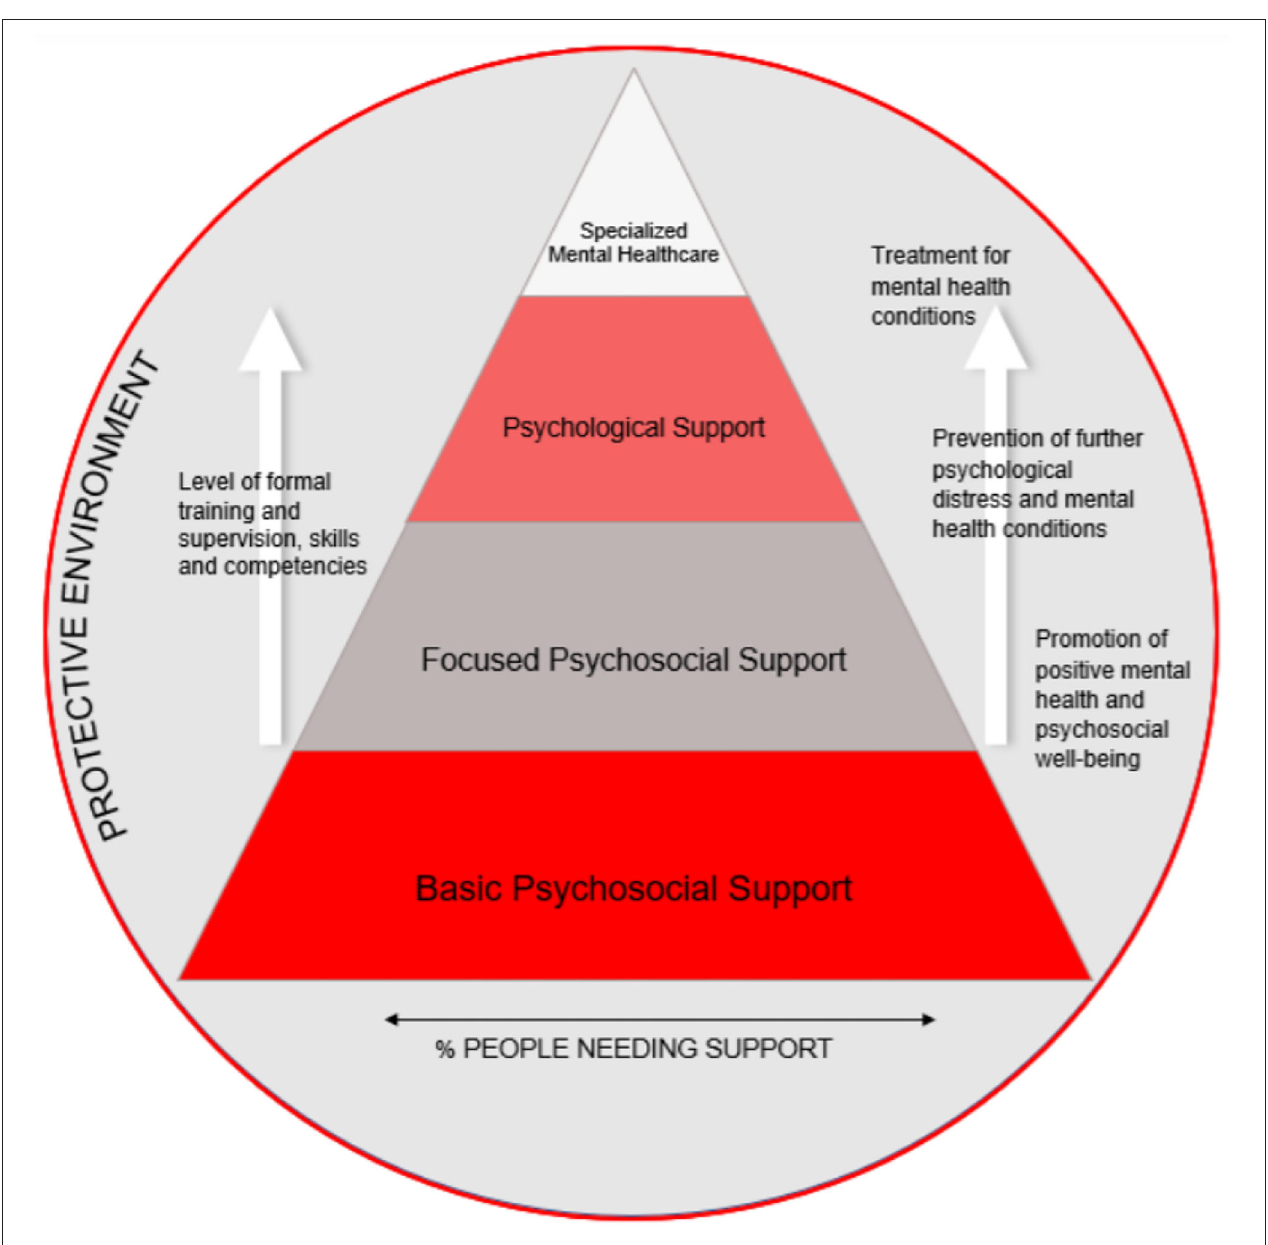
FIGURE 1 | MHPSS Movement